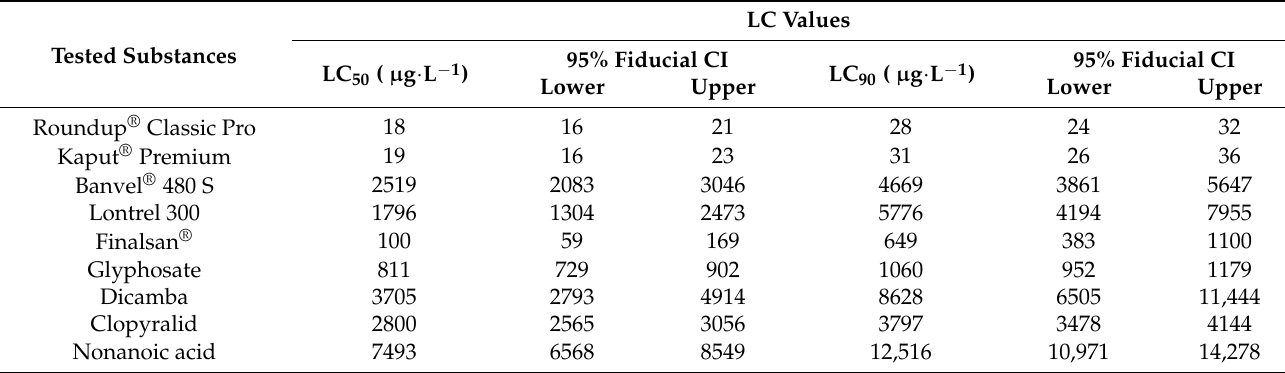
Table 2. LC 50 and LC 90 values of all tested herbicides and active substances and confidence intervals at 0.05 level of significance, tested organism A. salina